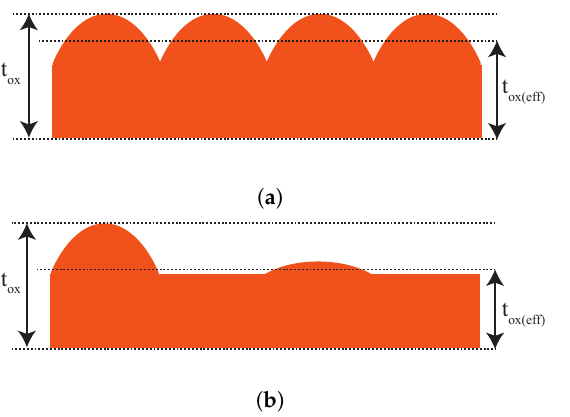
Figure 6. Graphical illustration of the film roughness deposited at ( a ) 300 °C and ( b ) 150